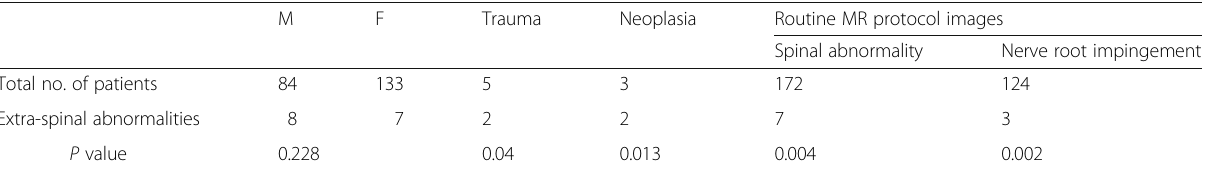
Table 3 Correlation between extra-spinal abnormalities detected on coronal STIR images and patients ’ sex, history of trauma, history of neoplasia, positive spinal abnormality, and signs of impingement on routine MR protocol images